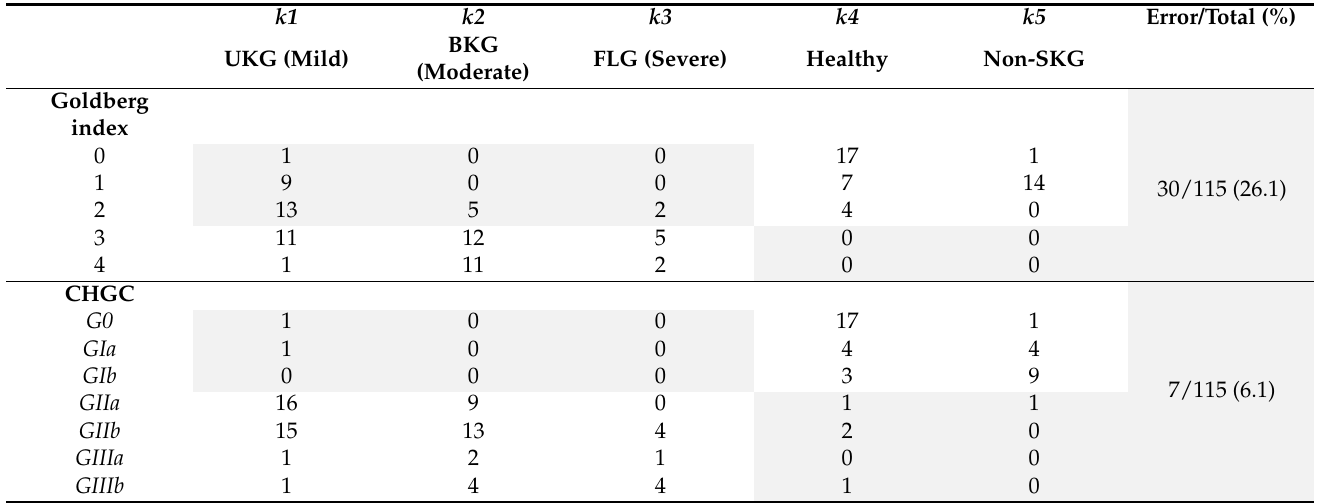
The clustering results, clinical and gait characteristics, and sagittal kinematic param-